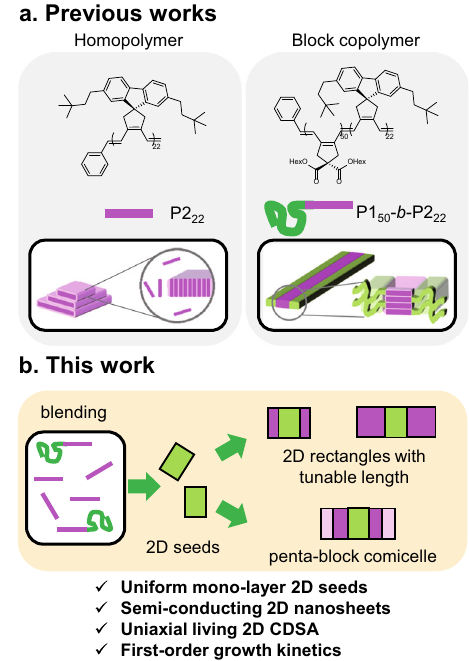
Fig. 1 Successful strategy to obtain uniform semi-conducting 2D rectangles by living CDSA. a Structures of the PCPV homopolymer and BCP and illustrations of the resulting 2D nanosheets and 1D nano fi bers from the PCPVs. The green color in polymer chains indicates a P1 shell block, and the pink color in polymer chains indicates a P2 core block. b Illustration of strategies for producing uniform 2D rectangles by living